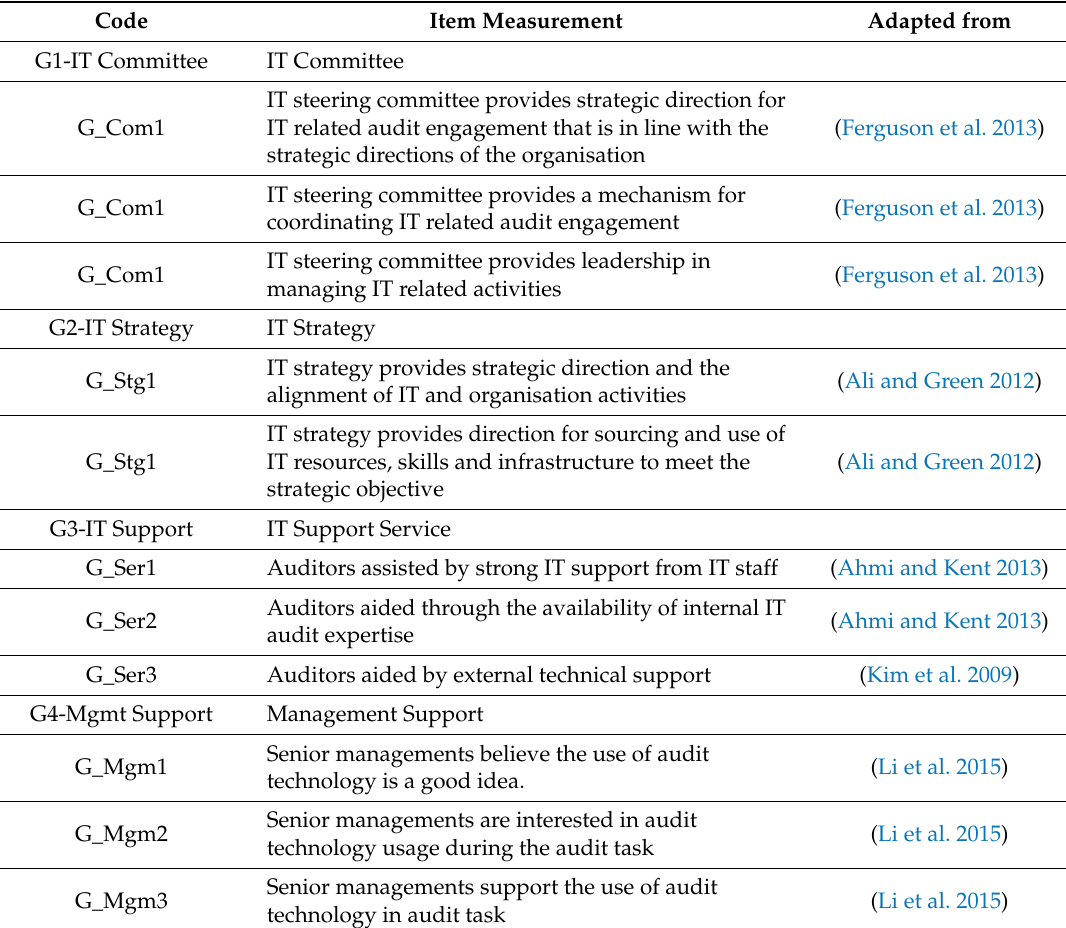
Table 1. Measurement items for IT